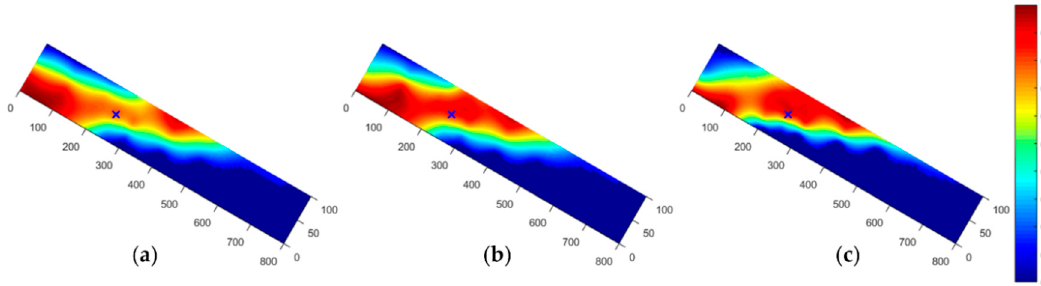
Figure 9. The oil distribution of different models after the shut-in stage. ( a ) Oil distribution of Exp1; ( b ) oil distribution of Exp2; ( c ) oil distribution of Exp4.